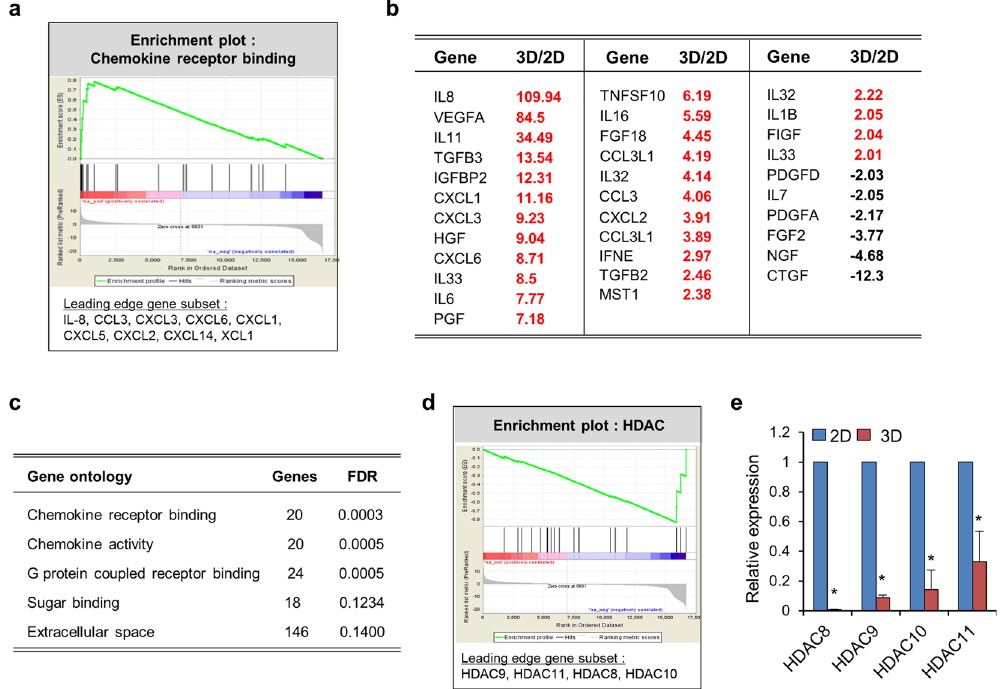
Figure 3. Transcriptomic changes in 3D spheroid MSCs. 3D and 2D MSCs were subjected to whole transcriptome sequencing and relative FPKM was calculated for differential gene expression. Preranked version of GSEA was performed for GO with significant enrichment. ( a ) Enrichment plots of GSEA with significant up-regulation in 3D with leading edge gene subsets indicated. ( b ) Fold changes of transcriptome for cytokine and growth factors in 3D MSC relative to 2D MSC. ( c ) List of significantly (FDR < 0.2) enriched gene sets (GO terms) in 3D MSCs. ( d ) Enrichment plots of GSEA with significant down-regulation in 3D MSCs with leading edge gene subsets indicated. ( e ) RQ-PCR analysis for expression levels of HDACs in 3D MSCs relative to 2D MSCs after normalization with GAPDH (mean ± SEM, from 3 experiments, n = 6; * p <